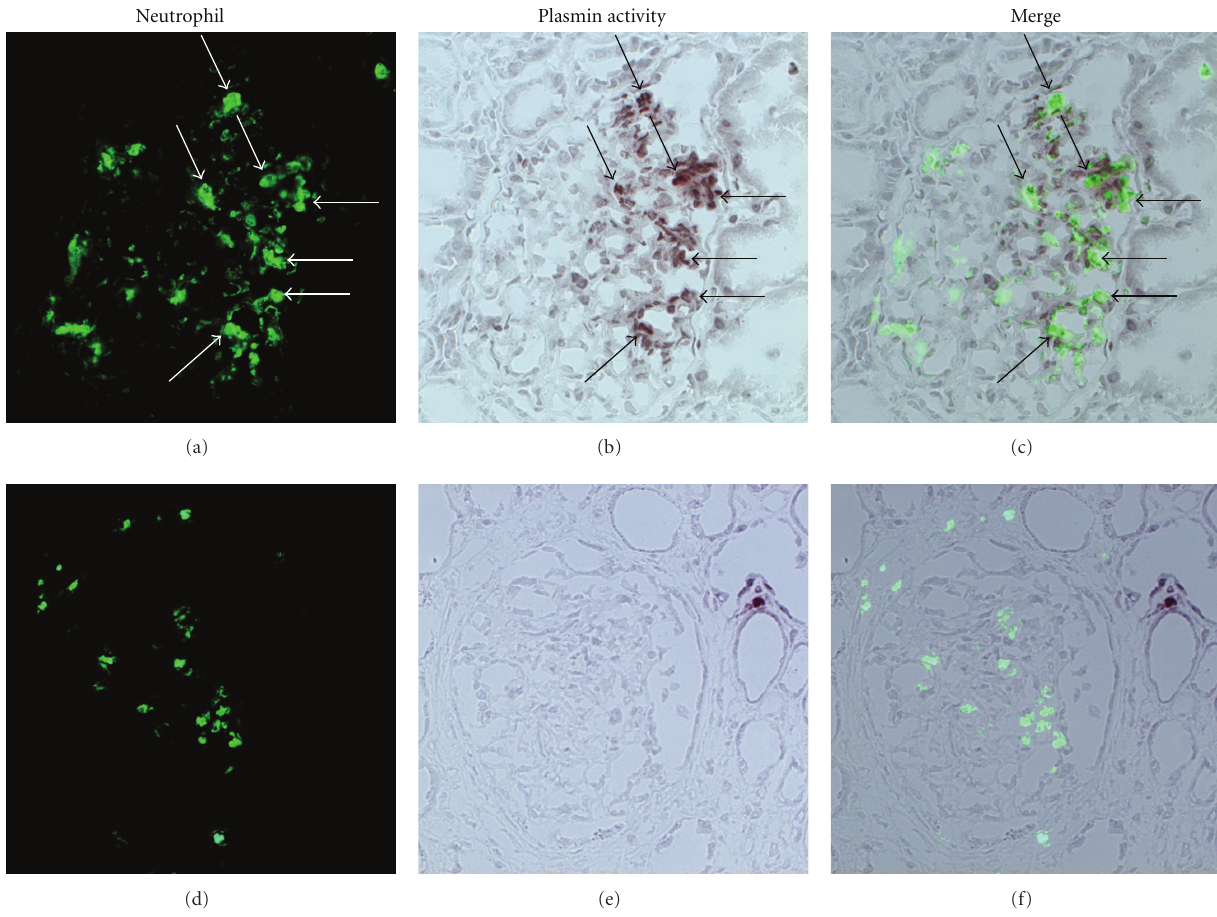
Figure 5: Glomerular infiltrating neutrophils and plasmin activity in APSGN and rapidly progressive glomerulonephritis. Representative photomicrographs of double staining for neutrophil elastase ((a) and (d), indirect immunofluorescence staining) and plasmin activity ((b) and (e), in situ zymography) from a patient with APSGN ((a)–(c)) and with rapidly progressive glomerulonephritis ((d)–(f)). The same fields were observed under fluorescence microscopy ((a) and (d)) and light microscopy ((b) and (e)) and were merged ((c) and (f)). The merged image (c) shows upregulated plasmin activity in a large portion of glomerular neutrophils in APSGN patients (indicated by arrows) but not in rapidly progressive glomerulonephritis patients (f) (original magnification × 260).